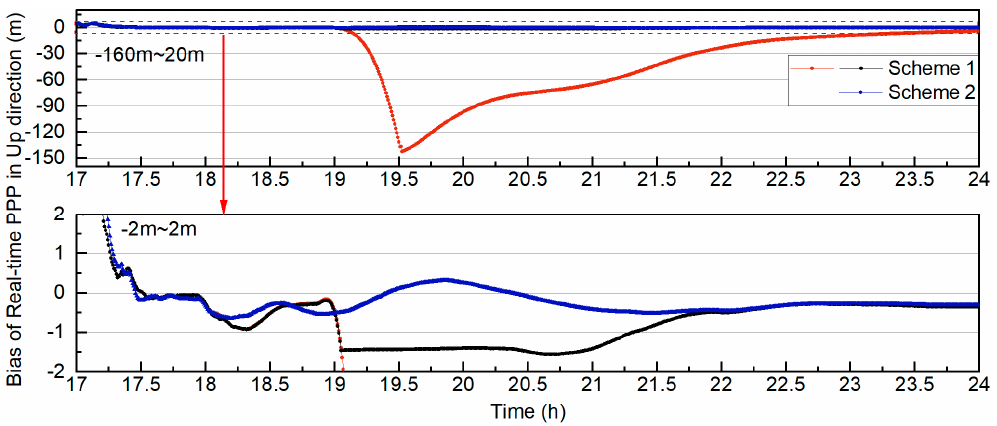
Figure 12. Bias of real-time PPP in the north.